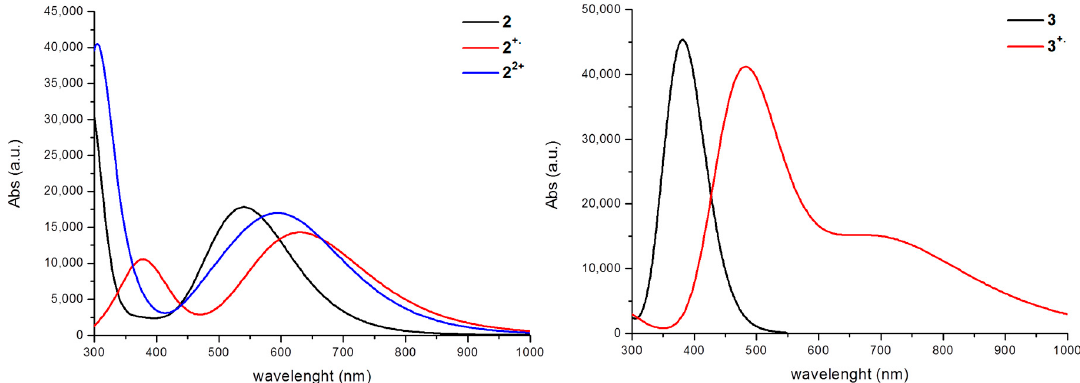
Figure 4. M06/6-31+G* computed absorption spectra for neutral and cationic species of compounds 2 and 3 .